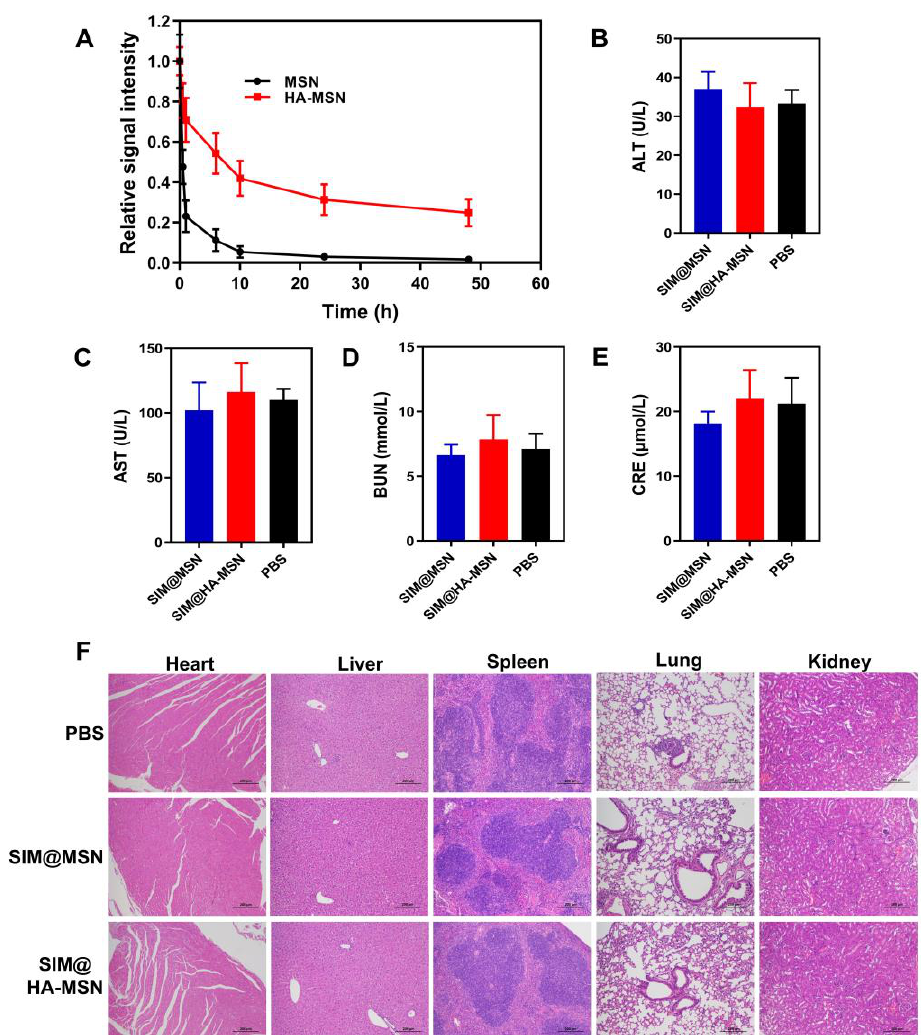
Figure 7. ( A ) Relative fluorescence intensity of FITC-labeled MSN and HA-MSN in blood over 48 h ( n = 6). ( B – E ) Serological biochemistry results of mice treated with SIM@MSN and SIM@HA-MSN at equivalent SIM concentrations for 4 weeks ( n = 6). ( F ) Representative images of H&E-stained sections of major organs from mice after different treatments for 4 weeks (scale bar = 100 µm).